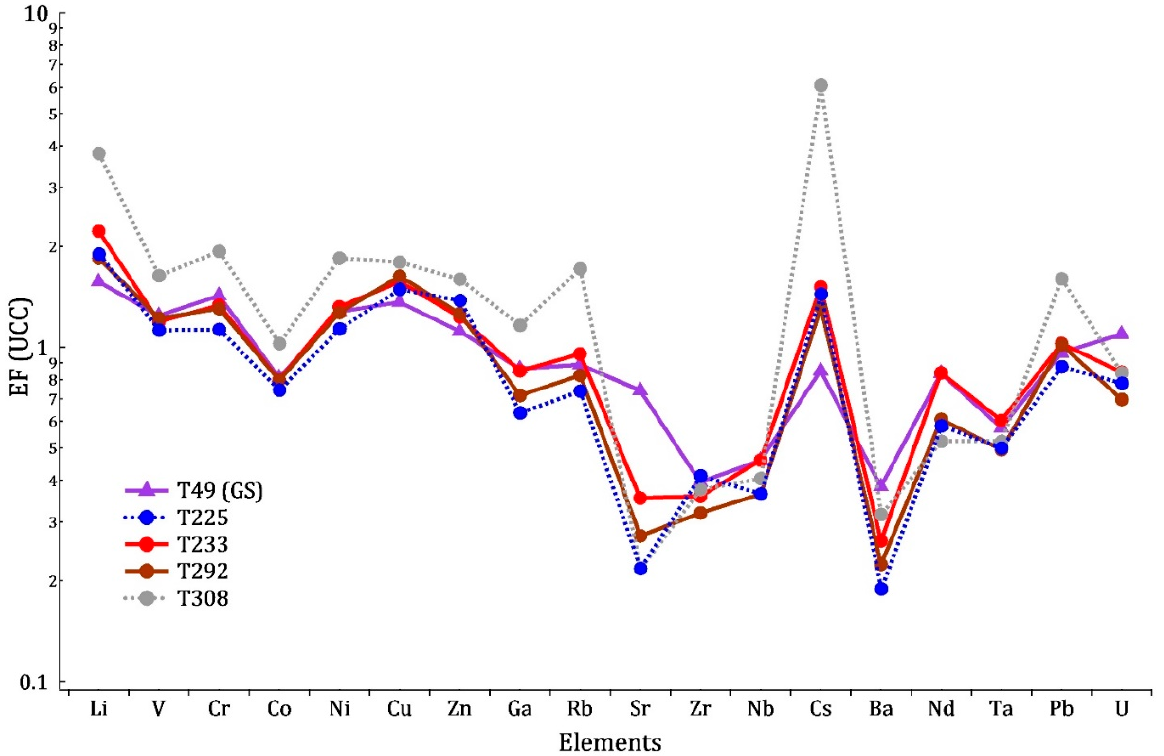
Figure 7. Enrichment factor (EF) of 18 TEs analyzed in GS and GP dust filters. EF is calculated using Ti as the TE of reference (Fe was not analyzed in the filters) and the Upper Continental Crust (UCC) [69] as the crustal reference.